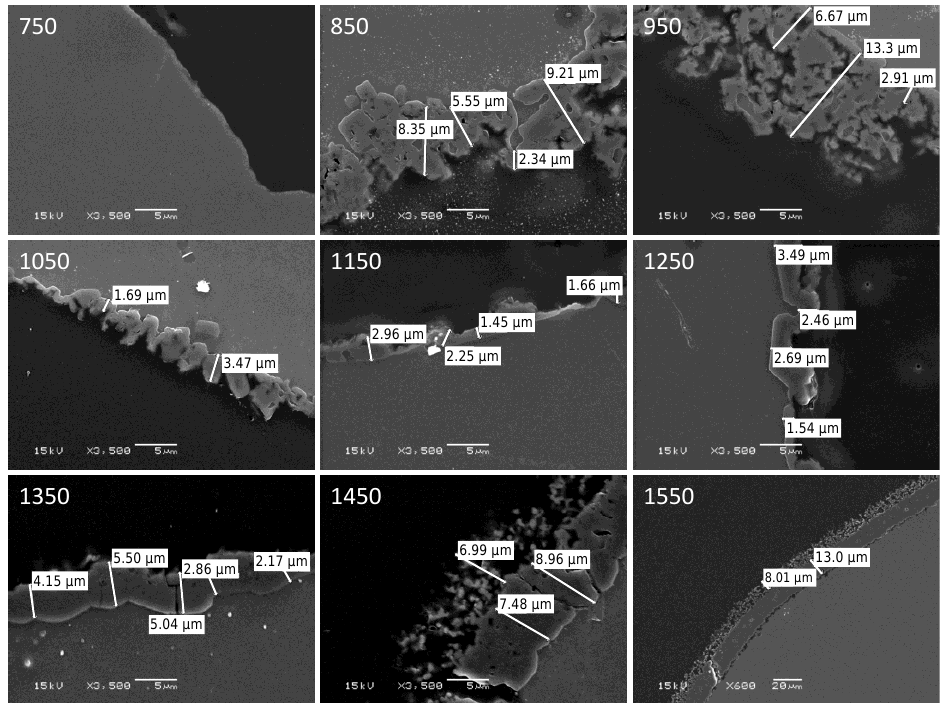
Figure 6. SEM images of cross sections of aluminum specimens after oxidation in air at the indicated temperature (°C). Note that all images are shown at the same magnification (scale bar = 5 μm), except for that of the specimen oxidized at 1550 °C (scale bar = 20 μm).